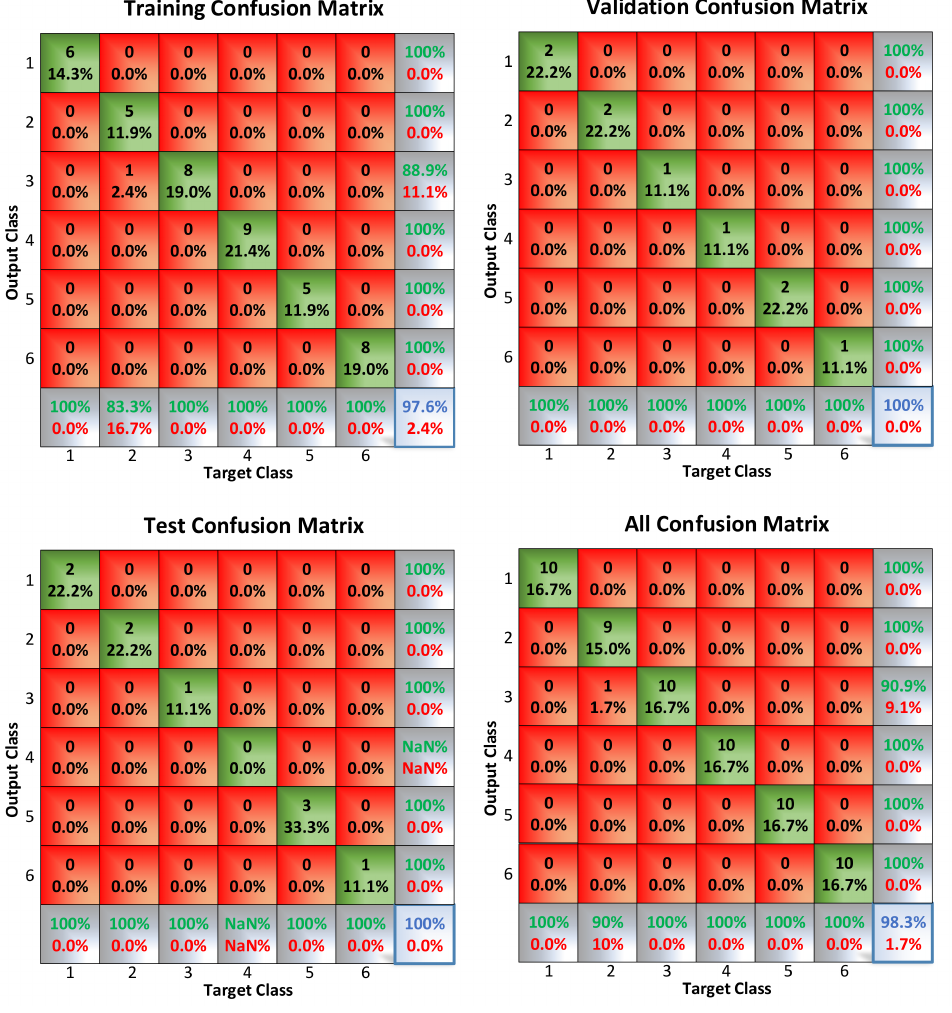
Figure 14. Training confusion matrix for sorting “Estilo Sevillano” processed